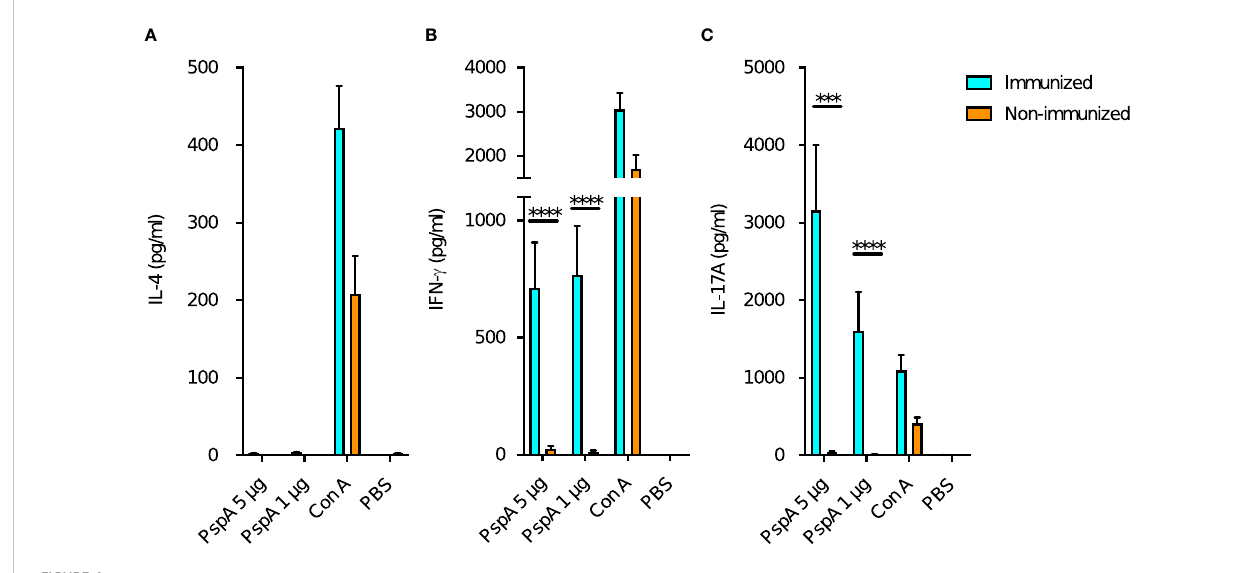
FIGURE 4 Cytokine production from maternal splenocytes by PspA stimulation. At the age of 8-week-old, the splenocytes from female mice were incubated with rPspA (1 or 5 µg) or concanavalin A (con A) for positive control. Cytokines in the supernatant were quanti fi ed by ELISA. (A) IL-4, (B) IFN- g , (C) IL- 17A. Data is shown as mean with standard error. Cyan bar and orange bar indicate immunized female (n=12) and non-immunized female (n=12) respectively. Mann-Whitney ’ s U test was performed for comparison between the groups. ***; P <0.001, ****; P